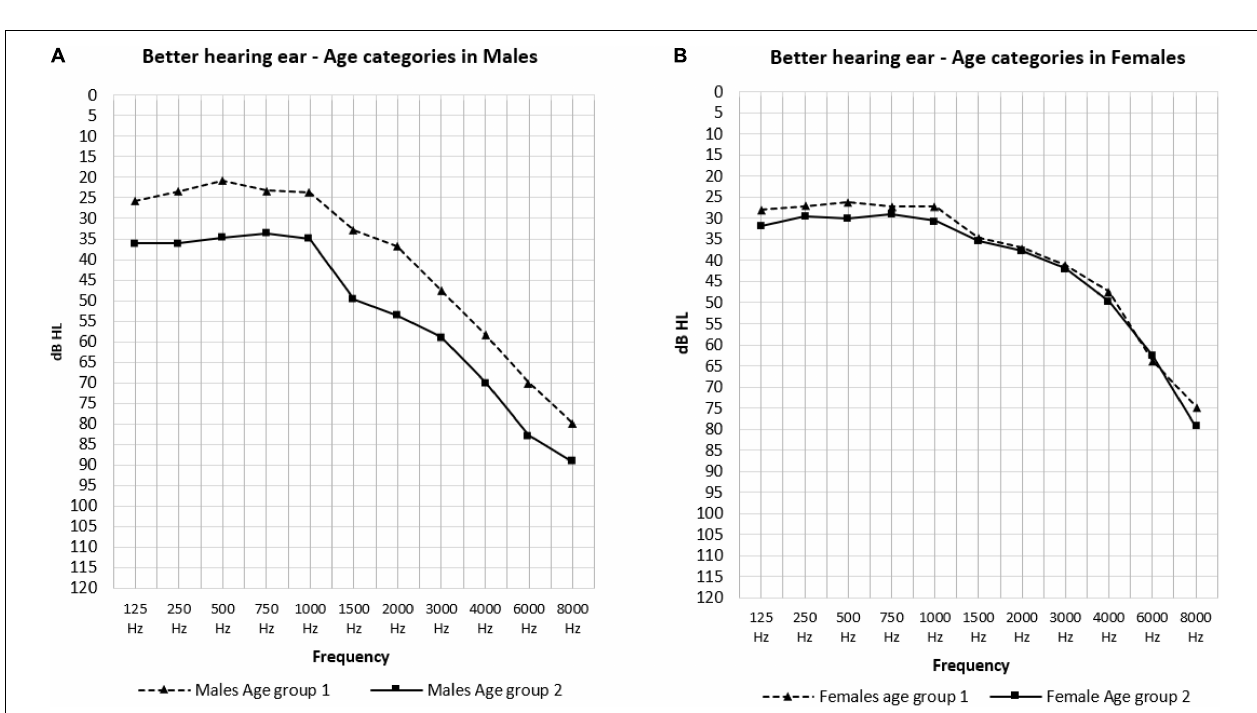
FIGURE 4 | The mean air-conduction thresholds (dB HL) in the better hearing ear according to age groups for males (A) and females (B) .